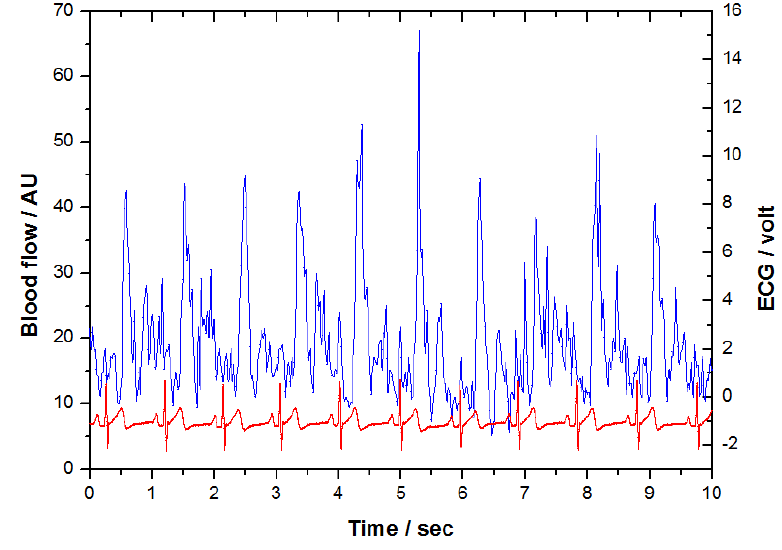
Figure 3. The typical blood flow signal determined by LDF (blue), plotted together with ECG signal